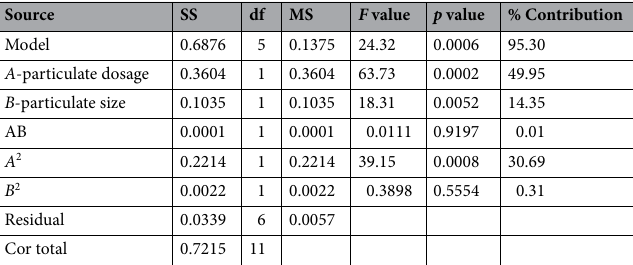
Table 7. ANOVA result on impact strength (1S). SS sum of squares, MS mean